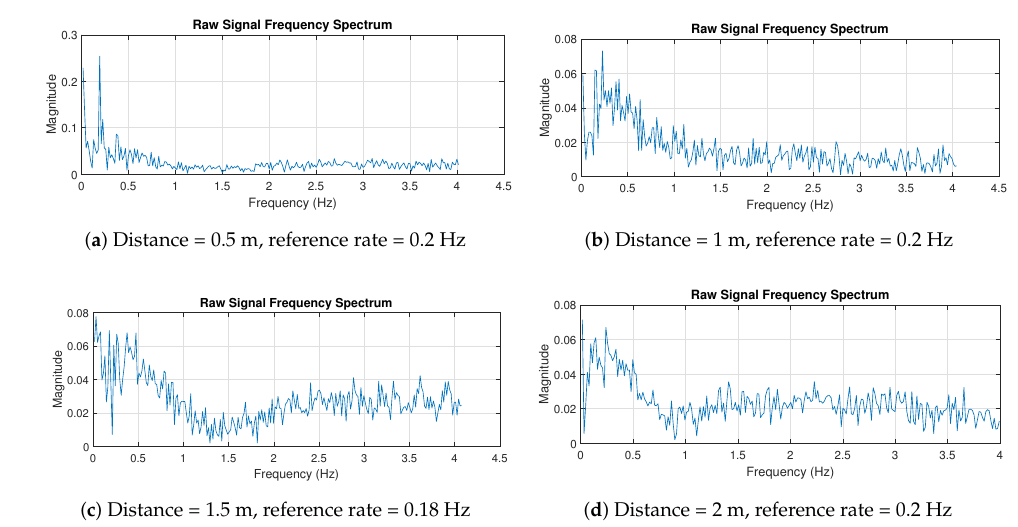
Figure 13. Experiment 2 results in frequency